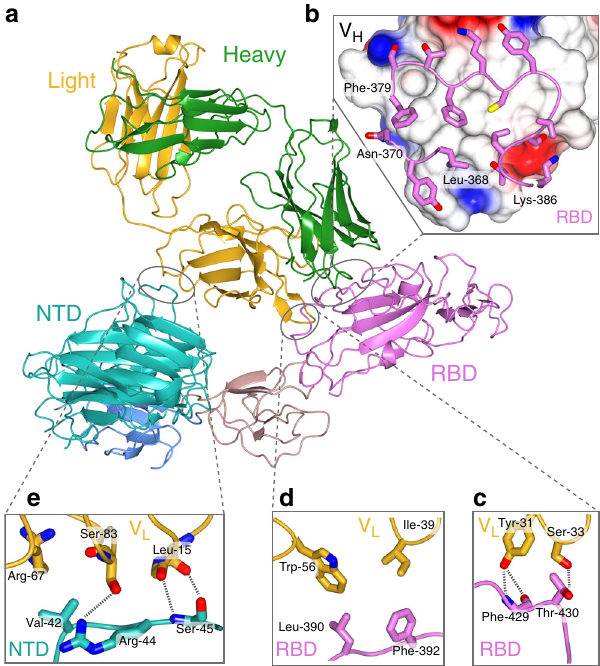
Fig. 2 Interactions between CR3022 Fab and SARS-CoV-2 spike protein. a Ribbon representation of the interactions between CR3022 Fab (with light chain in yellow and heavy chain in green) and the S1 domain of SARS-CoV- 2 spike (coloured according to Fig. 1). b Zoom view of the interaction between the Fab heavy chain, shown as a surface representation coloured according to surface potential, and a worm-and-side-chain representation of two stretches of RBD (residues 379 – 386 and 368 – 370) shown in pink. There is a notable hydrophobic component in the centre of the interaction with a number of electrostatic interactions on the outside. Interactions between CR3022 light chain (yellow) with RBD ( c , d ) and NTD ( e